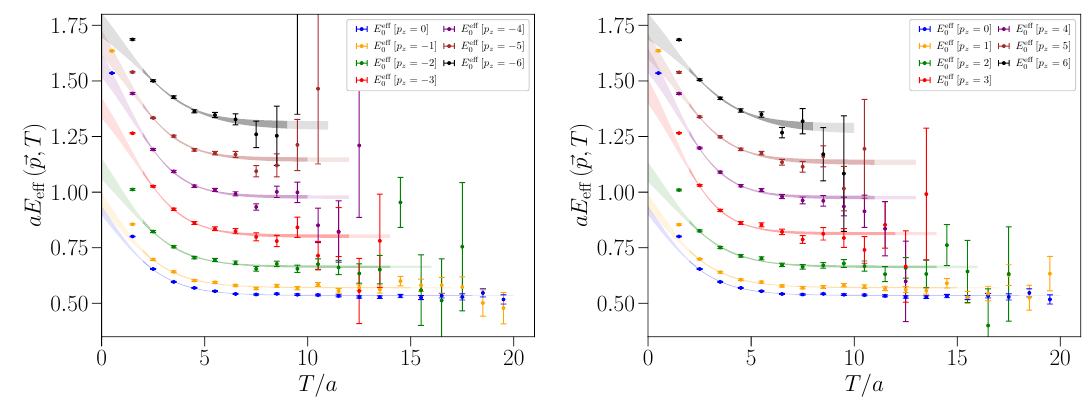
Figure 3 . Effective energies for each lattice momenta p latt with applied two-state fits. Time series included in each fit are indicated by darkened fit bands, and data are shown for signal-to-noise ratios greater than 2 . 25